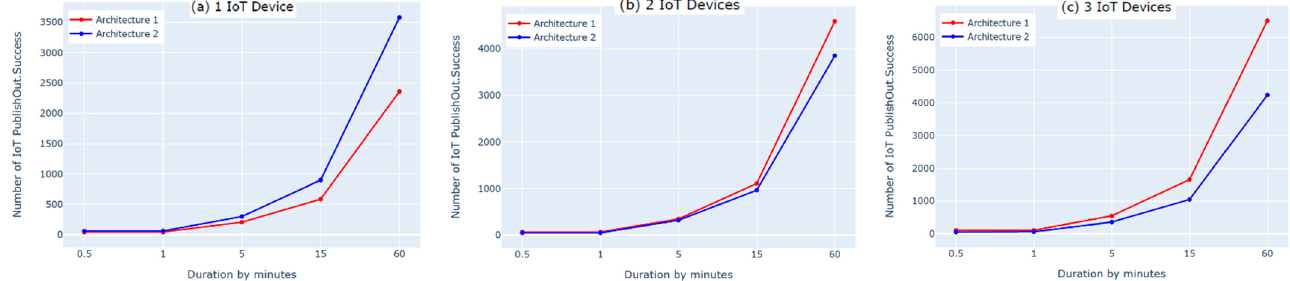
Figure 7. AWS IoT message broker PublishOut Success metrics with 1, 2, and 3 IoT devices on the North Virginia datacenter (cloud layer).